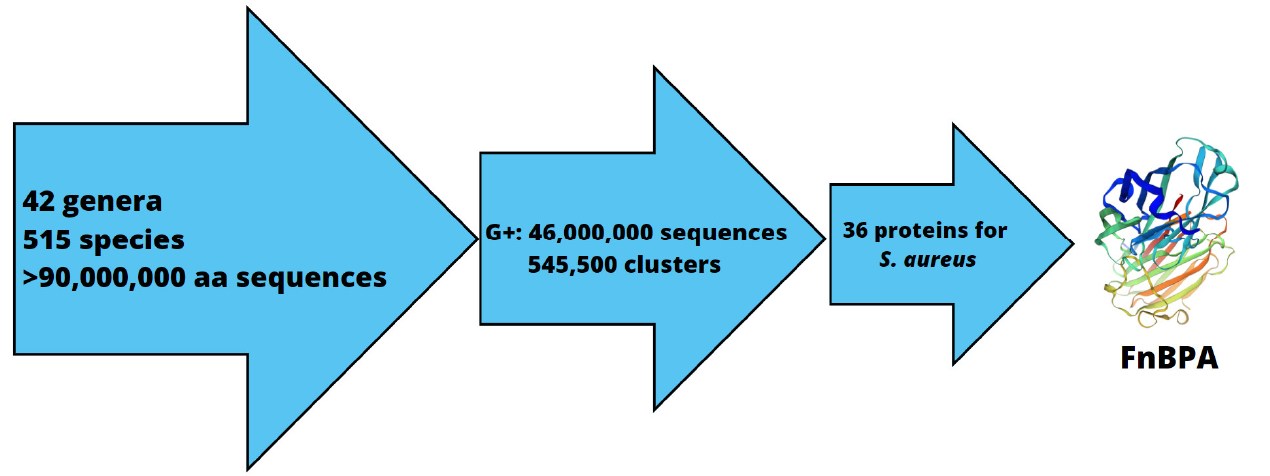
Figure 1. Scheme showing the stages of analysis leading to the identification of FnBPA for S. aureus , as a potential biomarker in an immunodiagnostic assay.